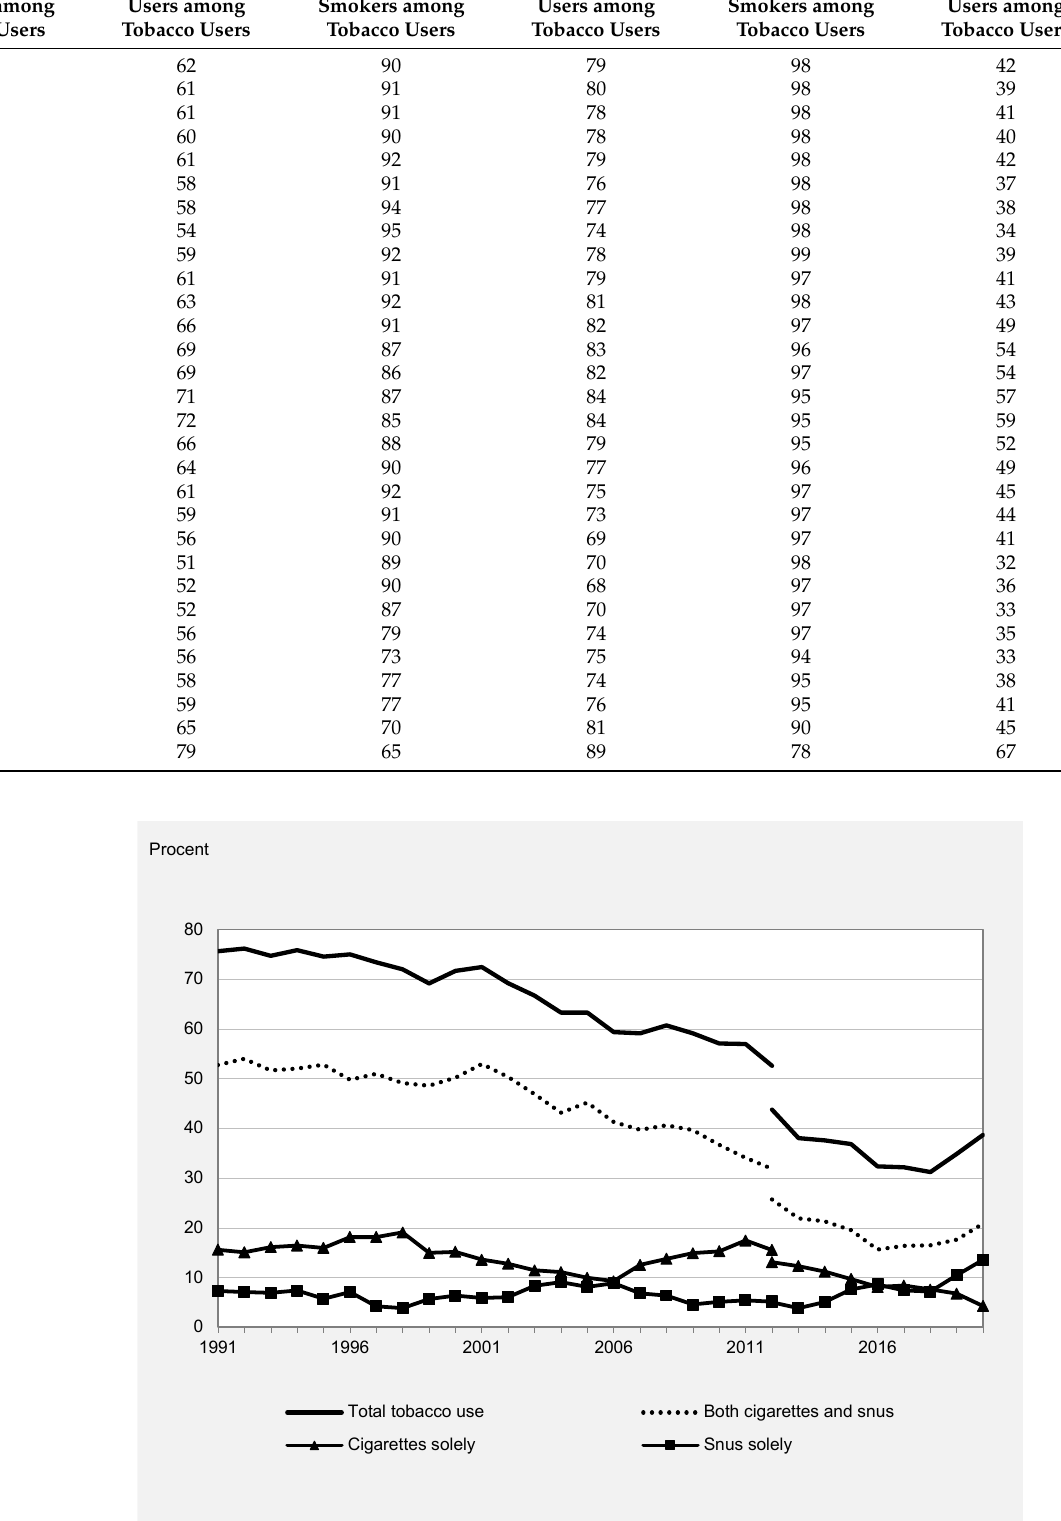
Figure 3. Use of tobacco among 15–16 ‐ year ‐ old females in Sweden, 1991–2020.